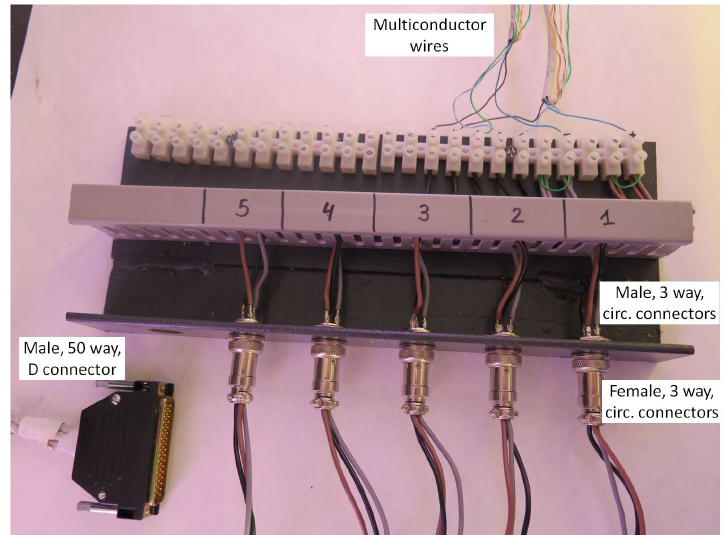
Figure 11. Detail of interfacing data acquisition board and infrared emitters and